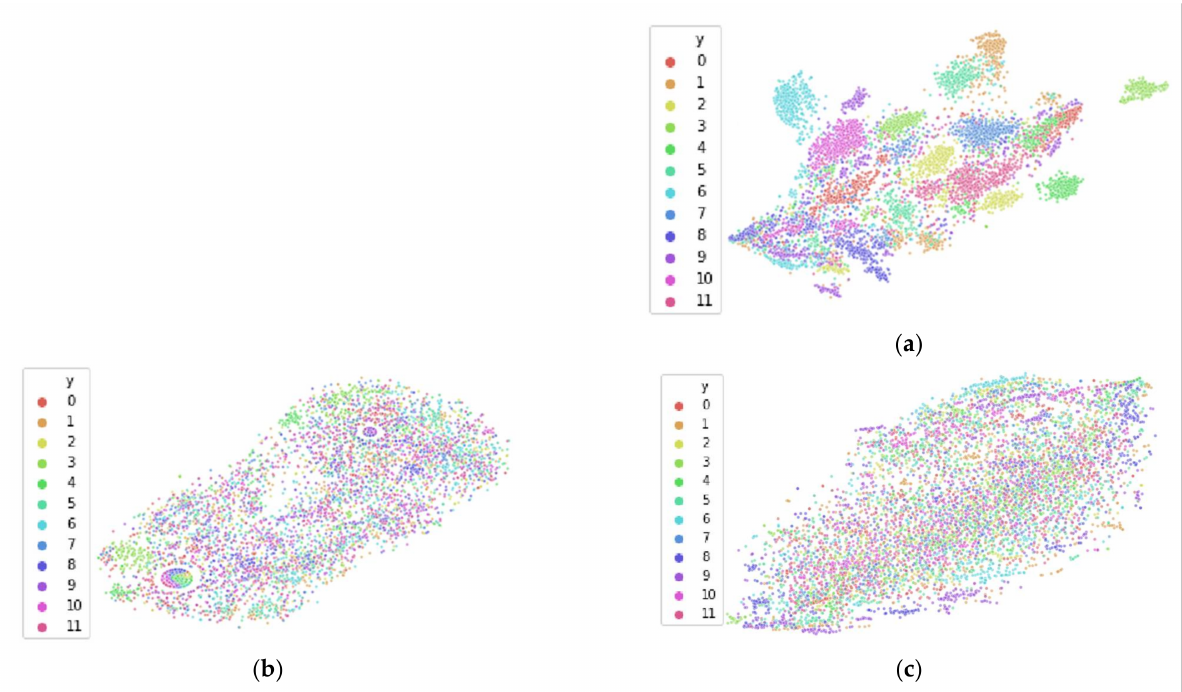
Figure 7. Results of visualizing the data using t-SNE for the entropy feature space before and after various data transforma- tions: ( a ) Before any transformations; ( b ) After applying shifted Heaviside transformation; ( c ) After applying shift to median transformation. Colors correspond to different participants, with the same color applied to the same participant in each figure. Note in ( b , c ) that there is a lack of local clustering, implying that inter-participant variability has been reduced due to the transformations. The dimensions of t-SNE are arbitrary distances which represent that closer neighboring points in low-dimensional space are likely to be neighbors in high-dimensional